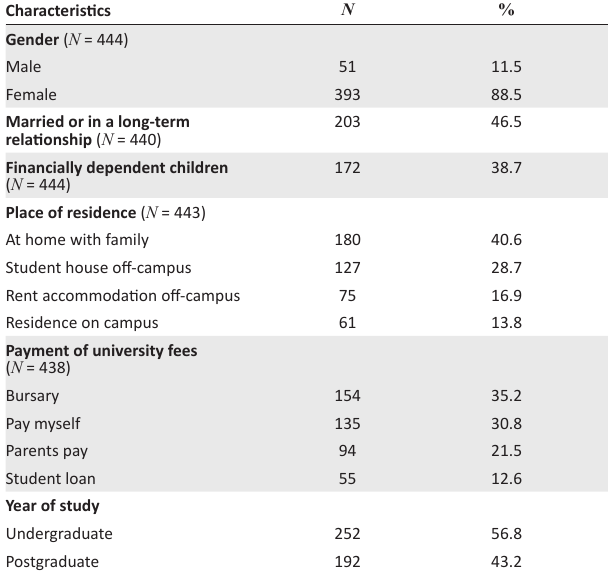
TABLE 2: Biographic information.